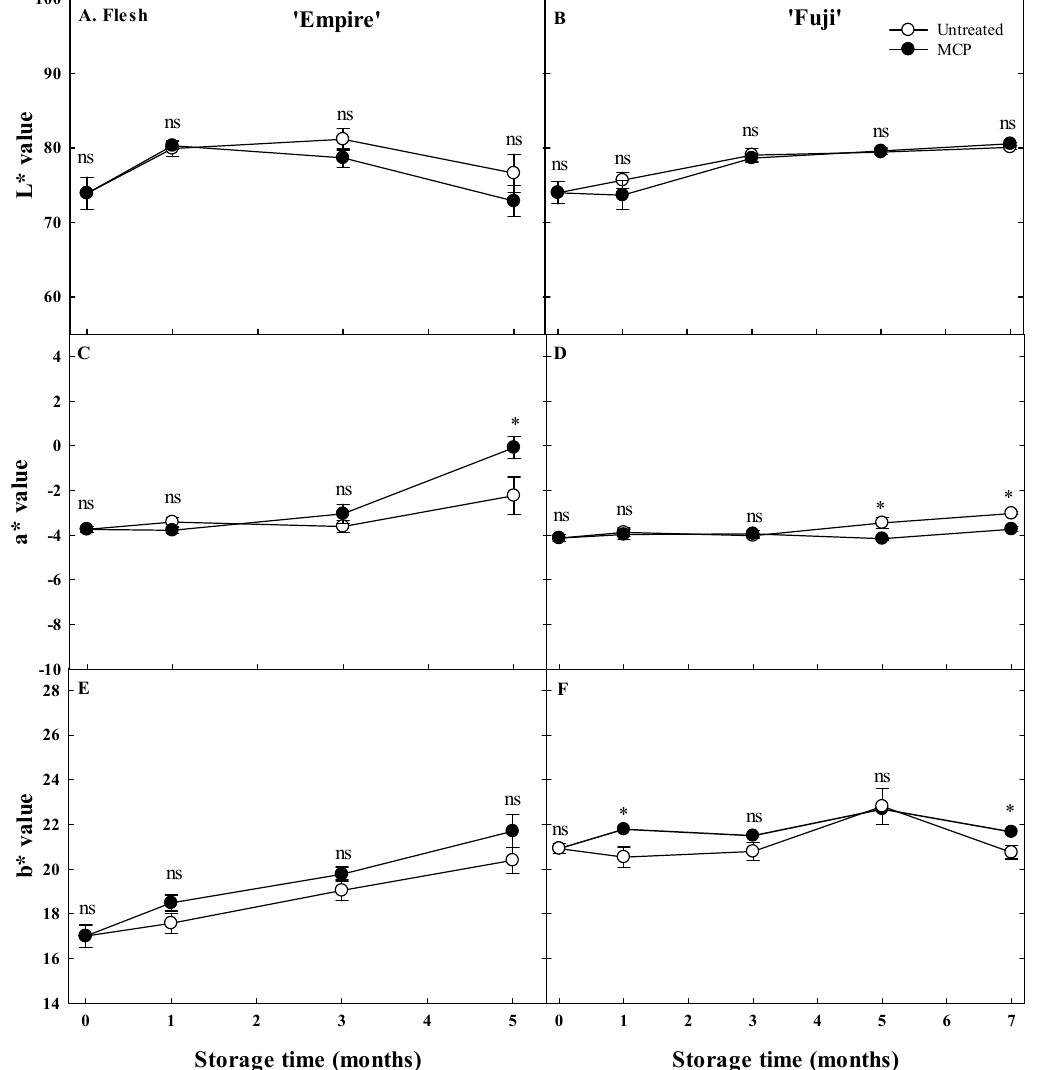
Figure 6. Color L* (lightness, A , B ), a* (red, C , D ), and b* (yellow, E , F ) values (of flesh tissue on ‘Empire’ and ‘Fuji’ apples, either untreated or treated with 1 µL·L − 1 1-MCP, and stored at 0.5 °C in air storage for up to five and seven months, respectively. Bars represent error of the means (S.E.M; n = 5) when larger than the dimension of the symbol. ns and * indicate non-significant and significant differences between untreated and 1-MCP treatments at p < 0.05, respectively.